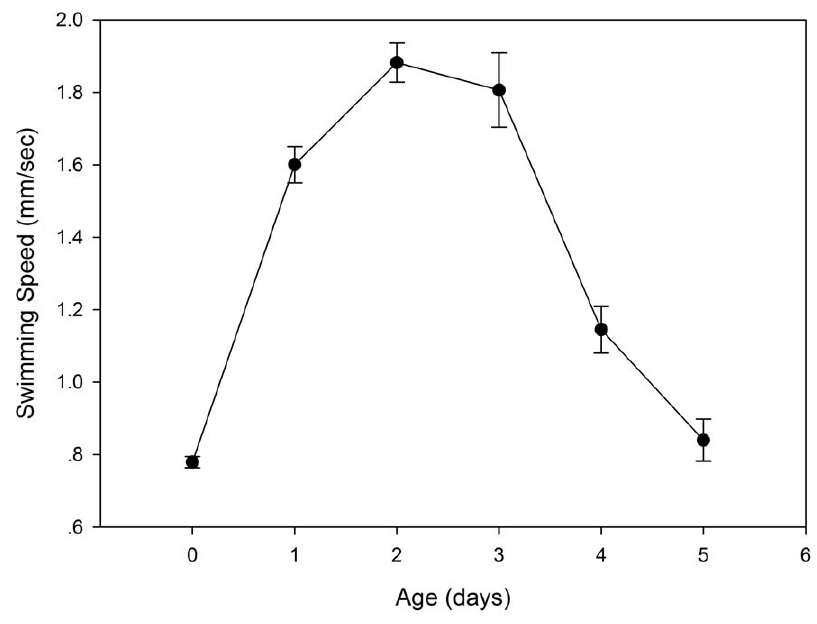
Figure 3. B.calyciflorus swimming speed (mm/s).